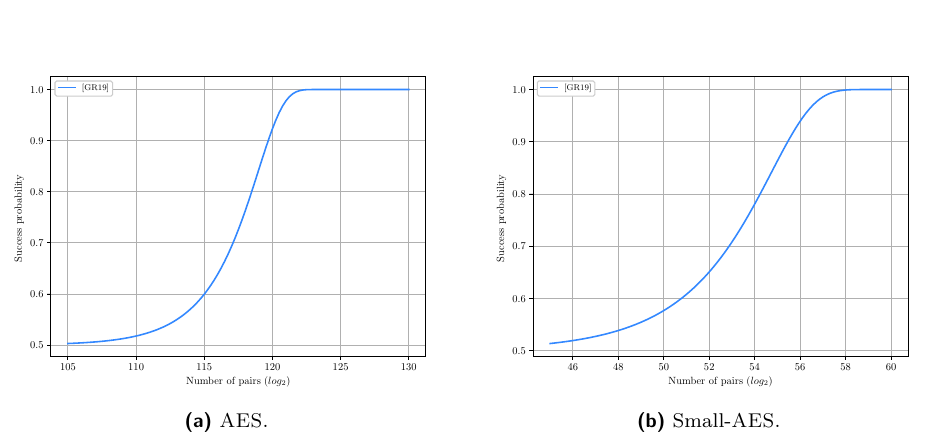
Figure 9: Success probability for the plausible range of the data complexity (number of pairs) for our six-round distinguisher, derived from Equation (5) from